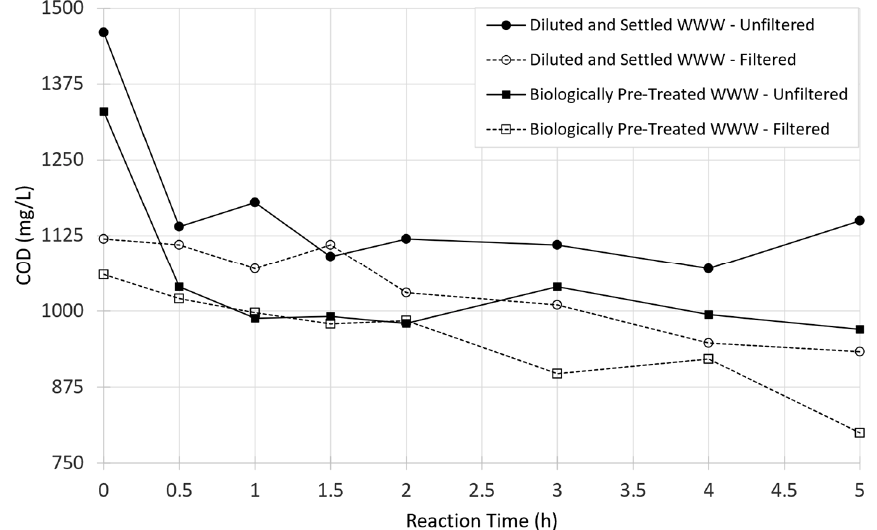
Figure 6. Evolution of COD concentrations during the Fenton-like treatment at H 2 O 2 2500 mg/L and Fe 3+ 325 mg/L of filtered and unfiltered WWW that had undergone first stage pre-treatment via settling and dilution or aerobic biological treatment.